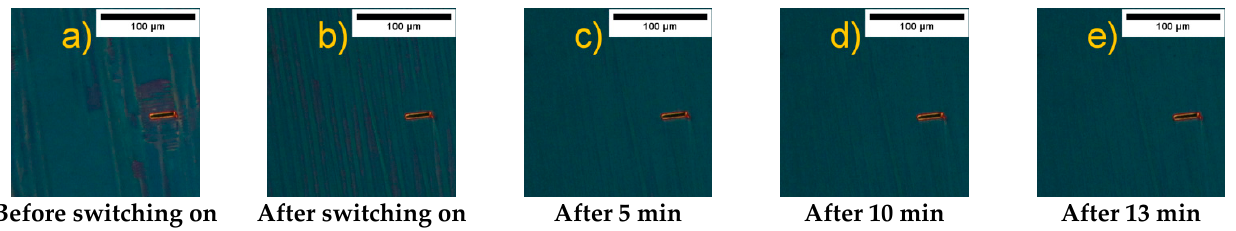
Figure 10. The alignment process of Composite 5 (20 V pp , 50 Hz, rectangular signal).